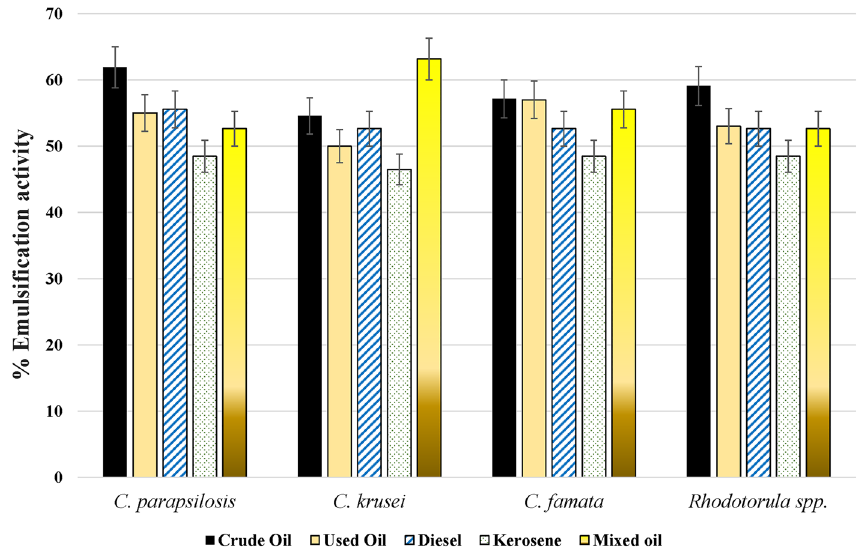
Figure 5. The emulsification activity effects of different yeast strains on tested hydrocarbons. CFSs of isolated strains were mixed with the tested hydrocarbons and incubated for 24 h at 25 °C. The percentage of emulsification was calculated by measuring the percentage of the higher emulsified layer to the total height of the